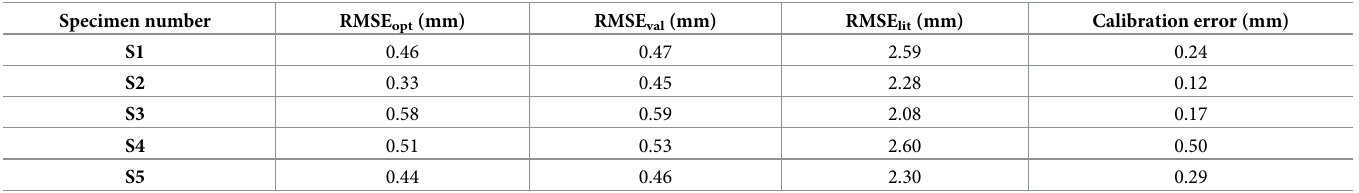
Errors are also presented for the five-fold cross validation (RMSEval − Column 3) and model evaluations using joint viscoelastic values from the literature (de Bruijn et al., [9]) that were used to initialise the models at the start of each optimisation (RMSElit − Column 4). Finally, the calibration error of the motion capture system for each experimental measurement is presented for comparison (Column